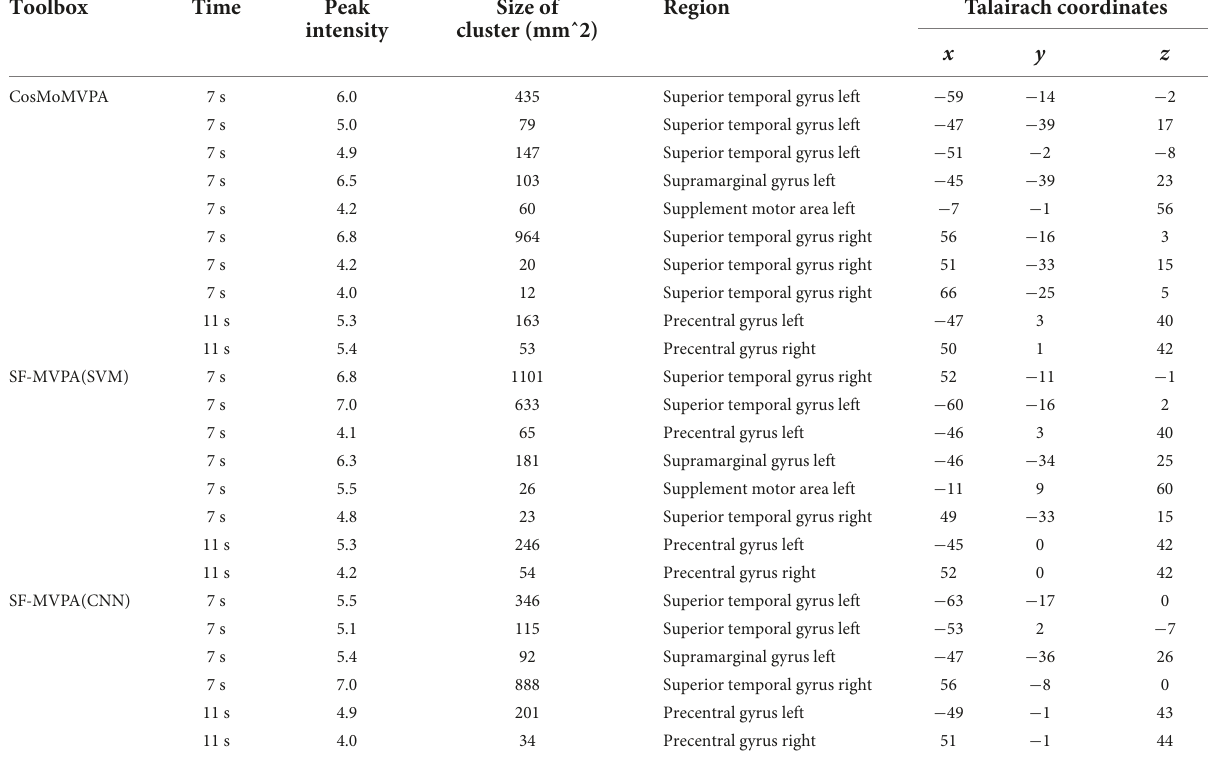
TABLE 1 Multivariate pattern analysis (MVPA) results of load 1 vs. load 4.